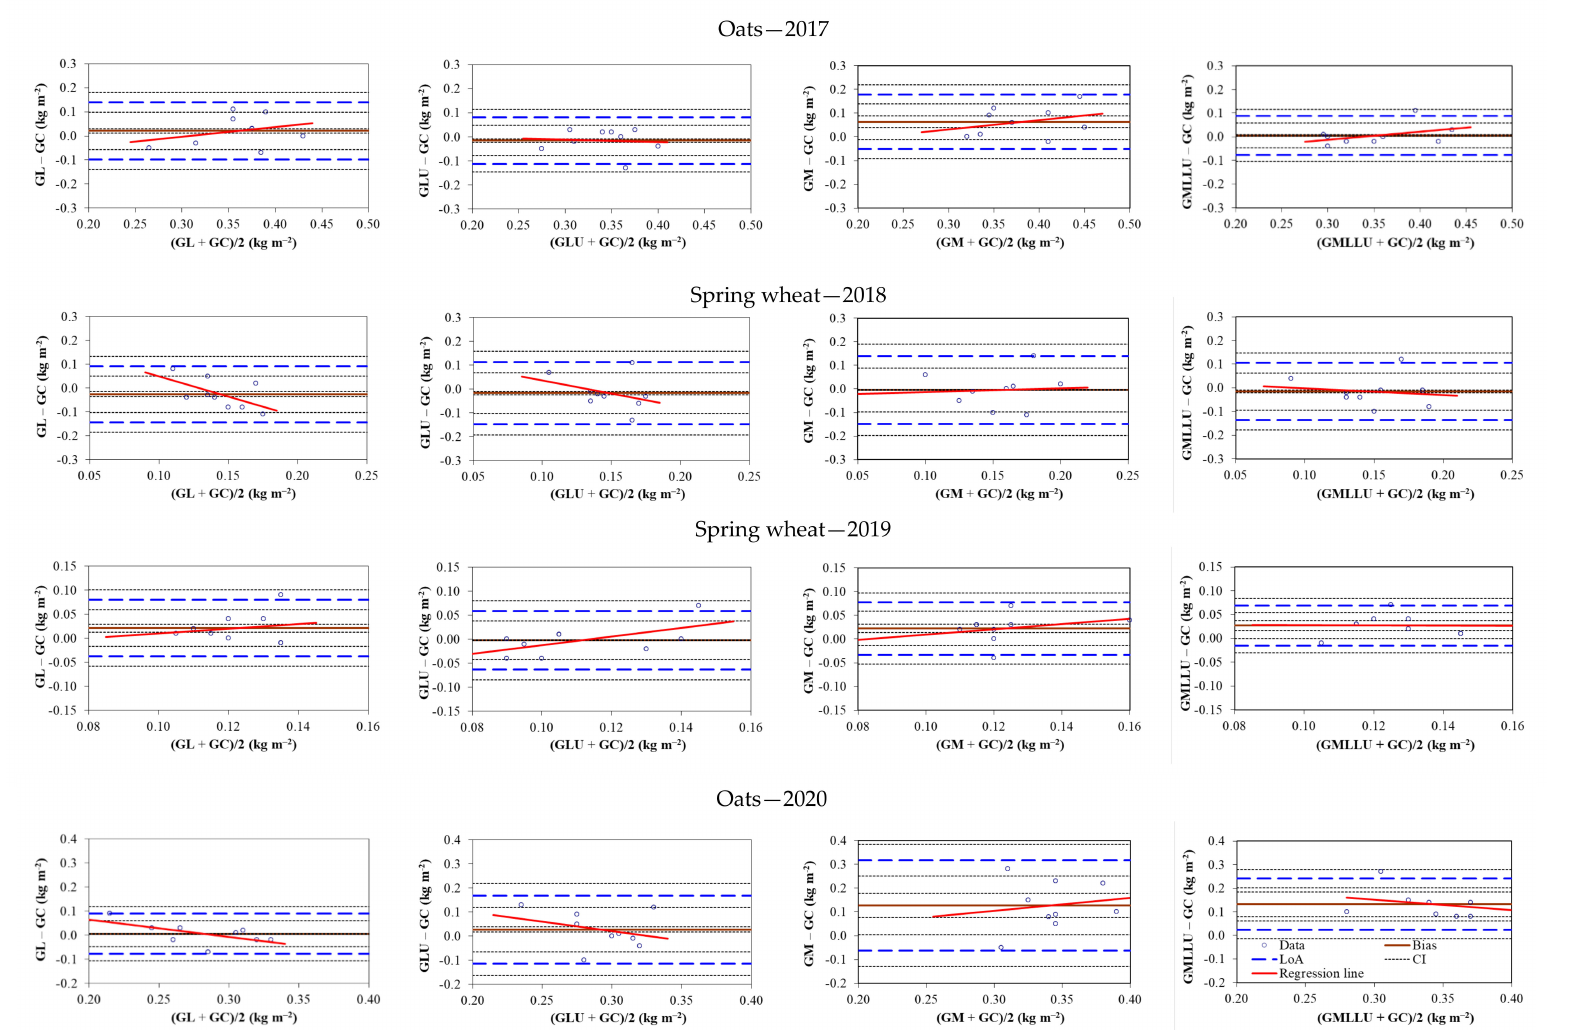
Figure 3. Bland–Altman plots for grain yield (G) (kg m − 2 ) (oats—2017), (spring wheat—2018, 2019), (oats—2020). C—control, L—liming, LU—leguminous catch crops, M—farmyard manure, and MLLU—farmyard manure + liming + leguminous catch crops, LoA—limits of agreement, CI—confidence